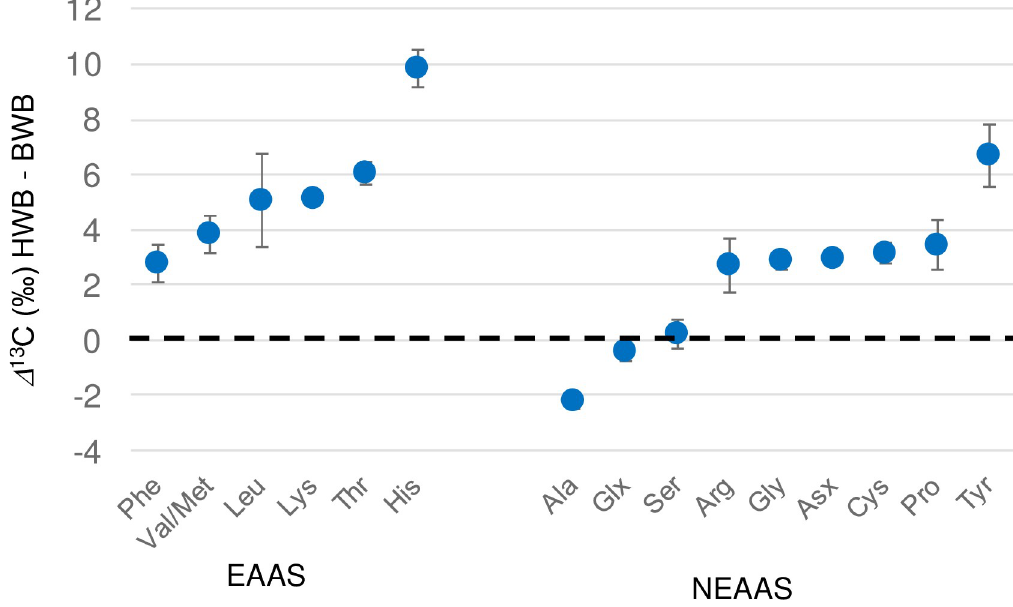
Fig 7. A comparison of the δ 13 C CARBOXYL composition of individual amino acids between HWB and BWB. Data for both samples are normalised to the calculated NCC composition. Widespread 13 C enrichment in the HWB is probably associated with the extensive fasting this species undergoes.